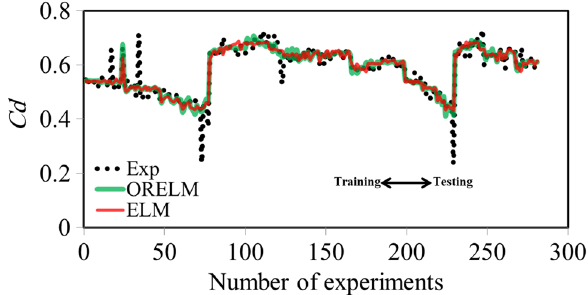
Fig. 11 Comparison of outcomes acquired by ORELM and ELM models with observed data in both